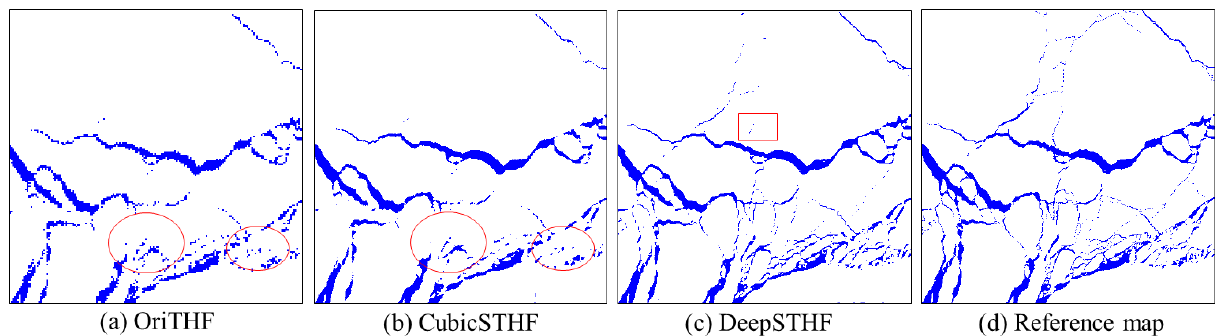
Figure 8. Lead maps generated from the simulated IST image using different methods. (a) The lead map generated by the OriTHF method; (b) the lead map generated by the CubicSTHF method; (c) the lead map generated by the DeepSTHF method; (d) the reference lead map extracted from the Landsat-8 operational land imager data. The lead and ice-covered areas are marked in blue and white, respectively. The red ellipses represent lead networks that have not been properly mapped by the OriTHF and CubicSTHF methods, and red rectangles indicate an area with very narrow leads that have not been mapped by the